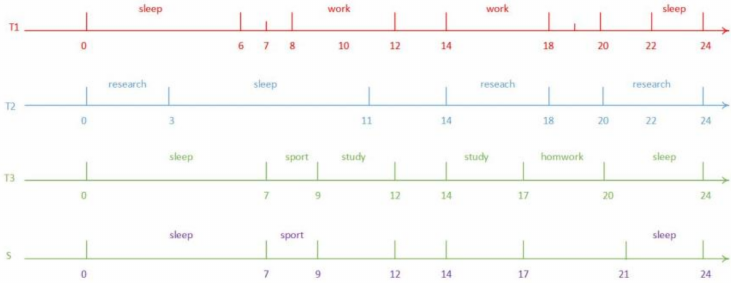
Figure 3. Daily timelines of worker, researcher, and